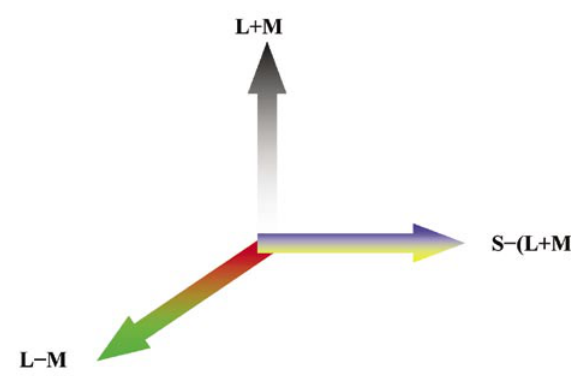
Figure 3 : A simple pseudo-3D colour space modi- 14 fied from Figure 16.1 of Krauskopf is indicated with orthogonal axes L−M, L+M and S−(L+M) re- spectively. The L+M axis is known as the luminance axis while the other axes represent the red-green and blue-yellow chromatic channels or